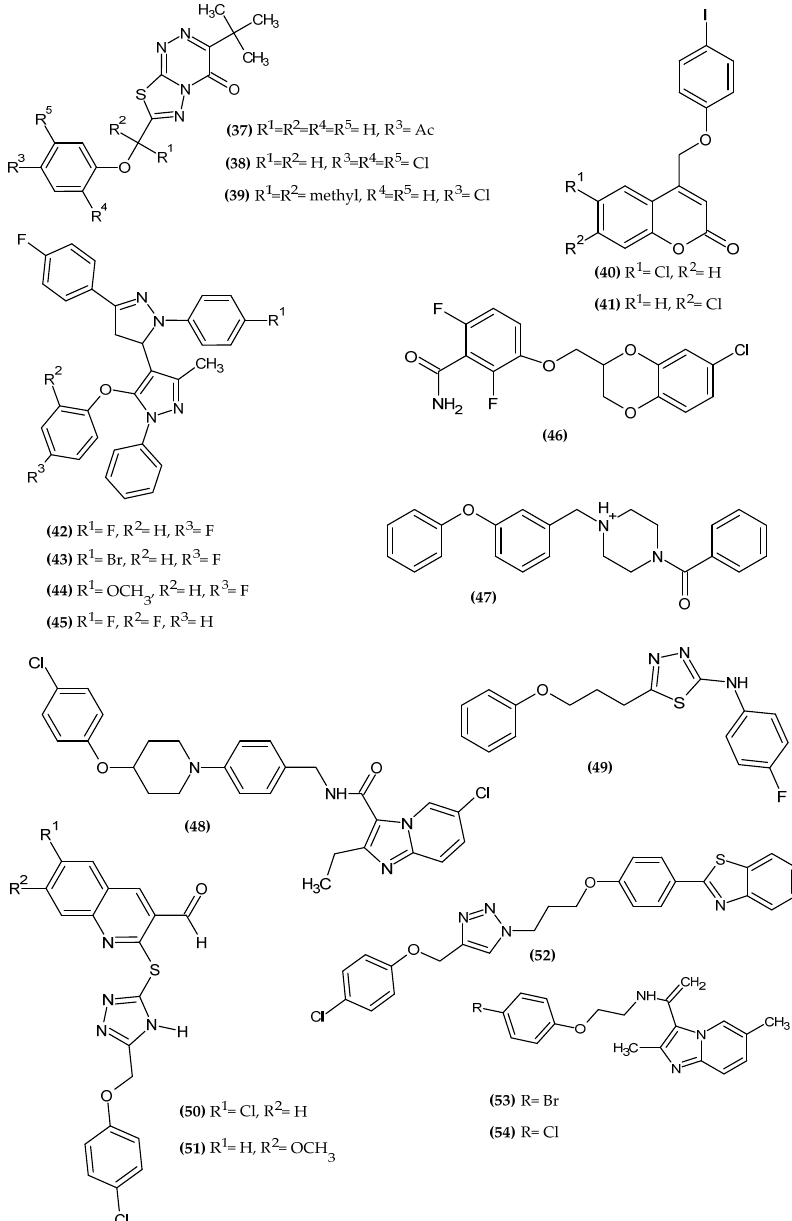
Figure 18. The novel potential agents with antimicrobial activity bearing a phenoxy group.